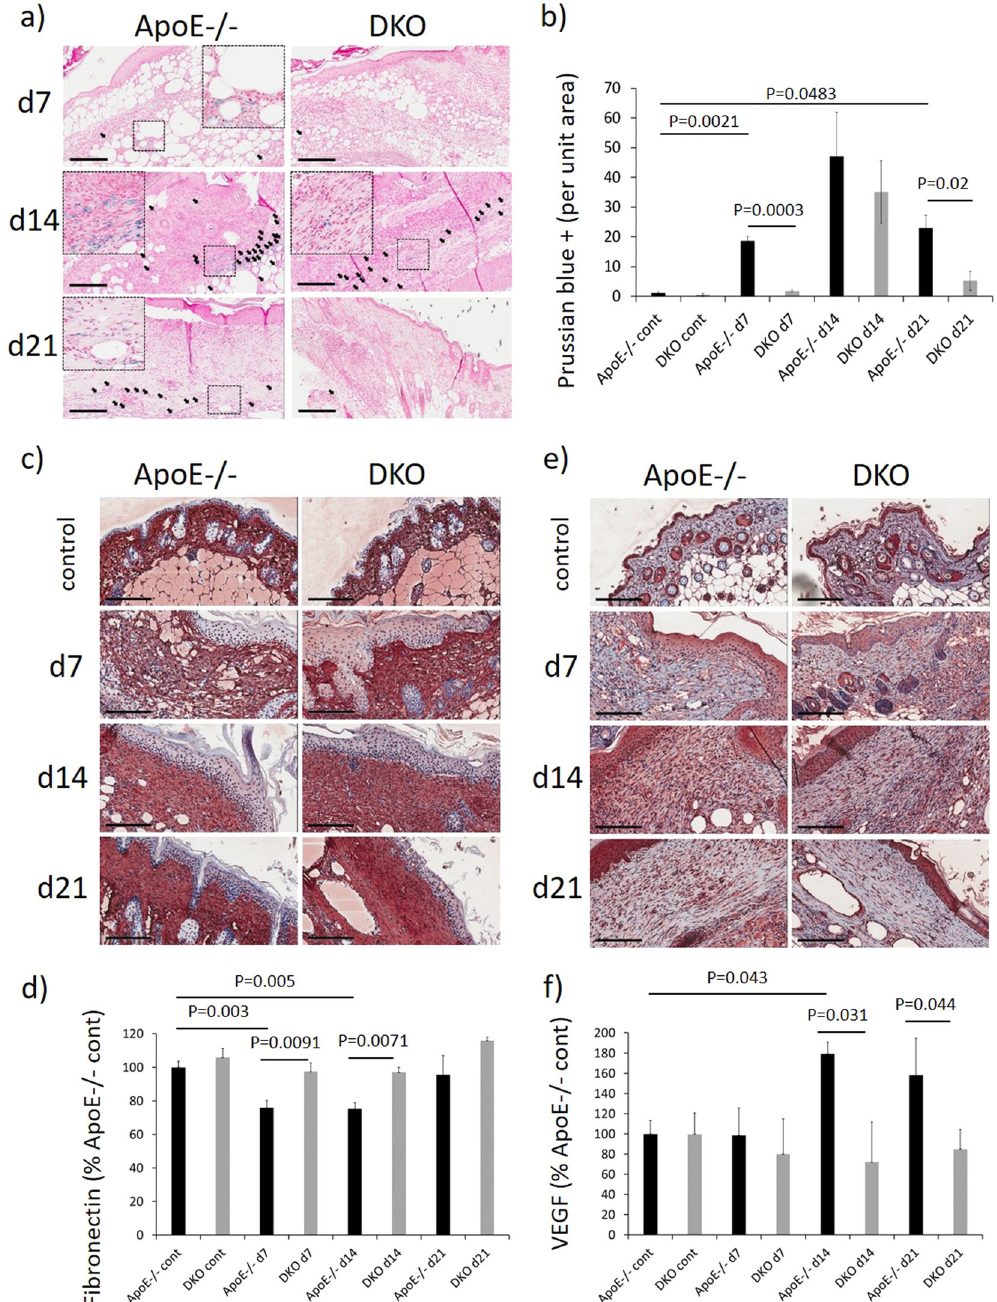
Fig. 4 Reduced micro-hemorrhage in DKO mice PI. a Representative images of Prussian blue staining ( a ), fi bronectin ( c ), and VEGF ( e ) immunohistochemistry in ApoE − / − , DKO mice PI and unwounded controls. Scale bars = 300 µm ( a ) and 200 µm ( c , e ). Quanti fi cation of Prussian blue ( b ), fi bronectin ( d ), and VEGF ( e ). Data analyzed by two-way ANOVA with Bonferonni post-test and presented as Prussian blue staining per unit area ( b ), fi bronectin ( d ), or VEGF (e) staining intensity in the dermis as a percentage of ApoE − / − unwounded control skin, mean ± SEM, n =